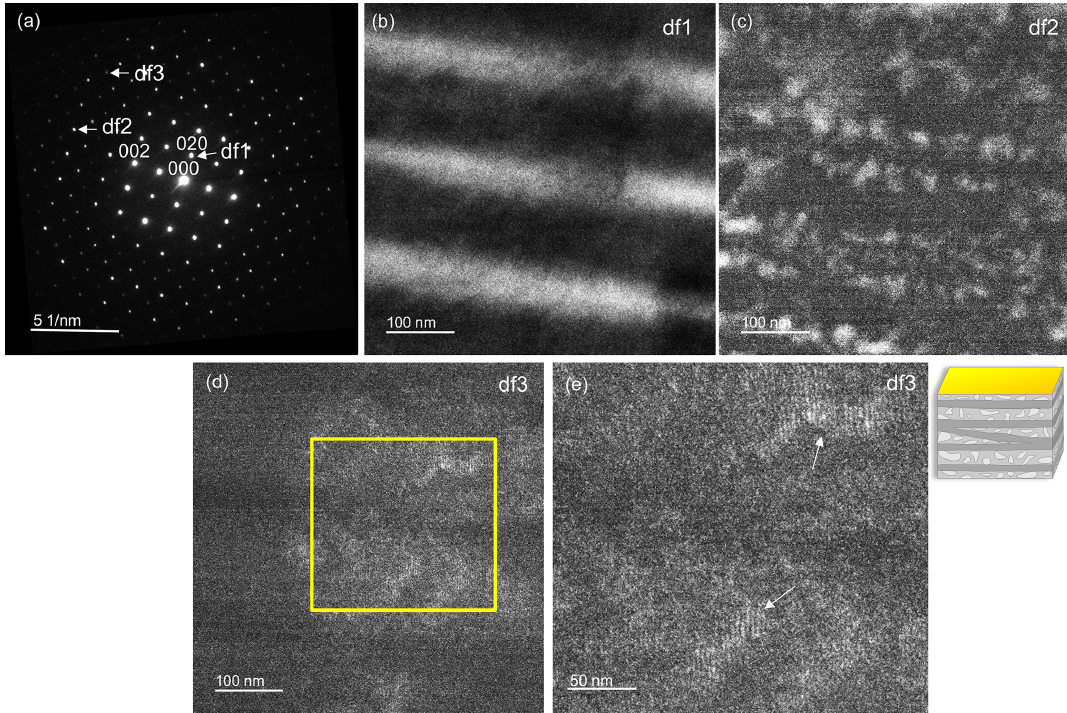
Figure 6. (a) TEM diffraction image along the [100] zone axis of the labradorite matrix. Selected diffraction points df1–df3 are marked by arrows and displayed in TEM dark-field images ( b – e ). (b) Dark-field image of 020 where the Ca-rich (dark) and Ca-poor (light) lamellae are visible. (c) Dark-field image of a pair of e -satellites between 014 and 015. Domains in the lamellae become visible. (d) Dark-field image of 064. The yellow framed area is enlarged in (e) and displays e -fringes in some areas with a distance of approximately 3nm. Insert to the right of (e) was taken from Fig. 3.